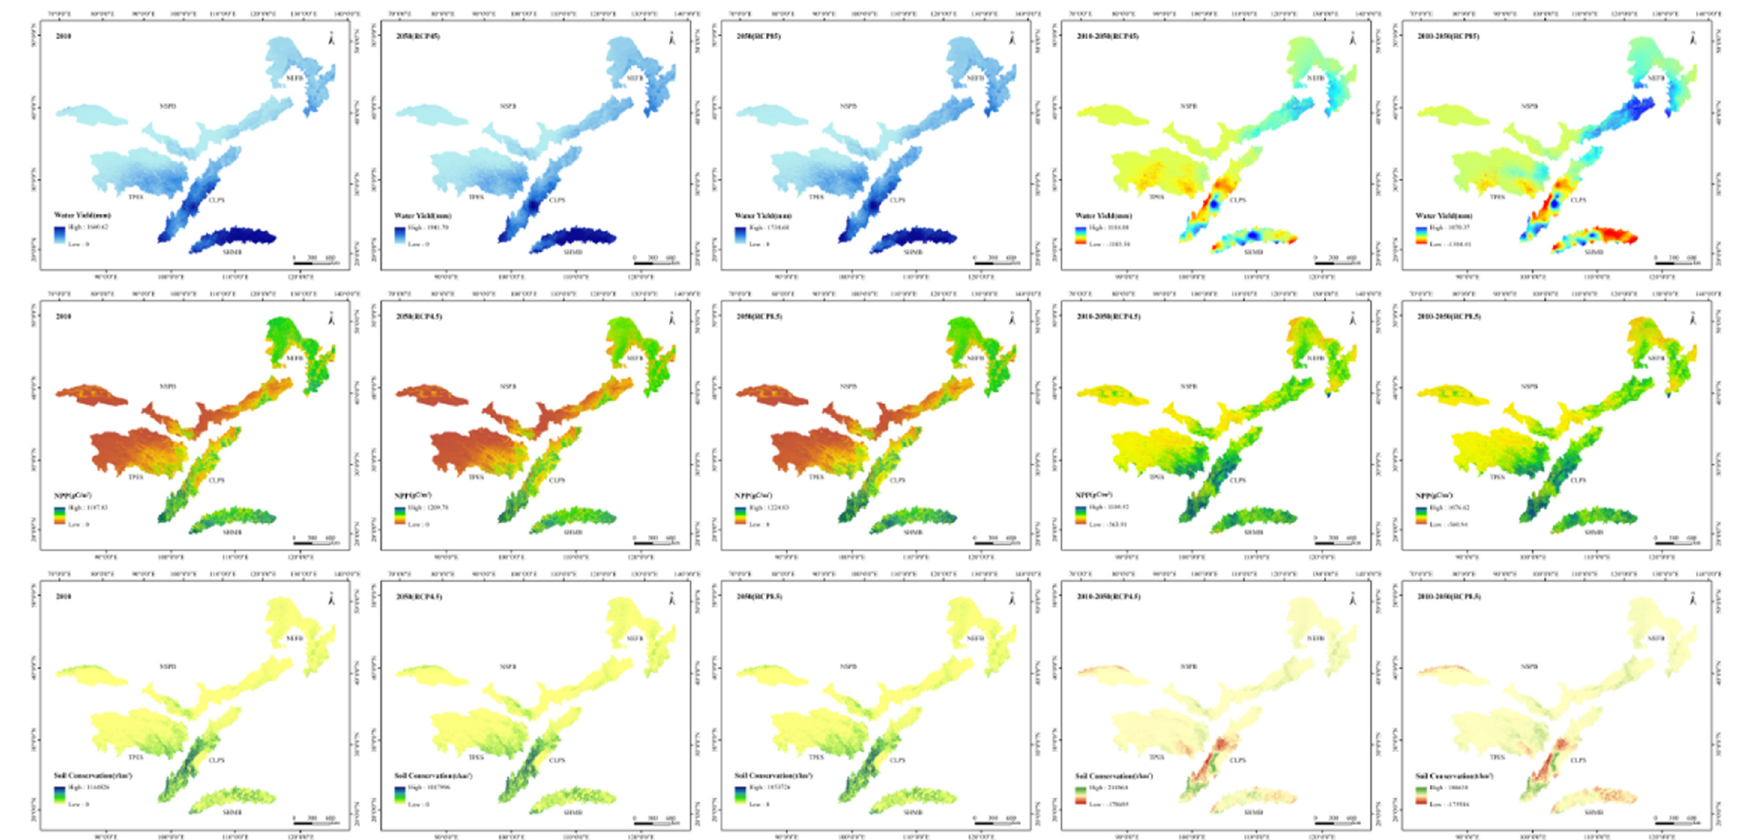
Figure 5. Spatial distribution and the difference between 2010 and 2050 of water yield, NPP and soil conservation in the TSTB.